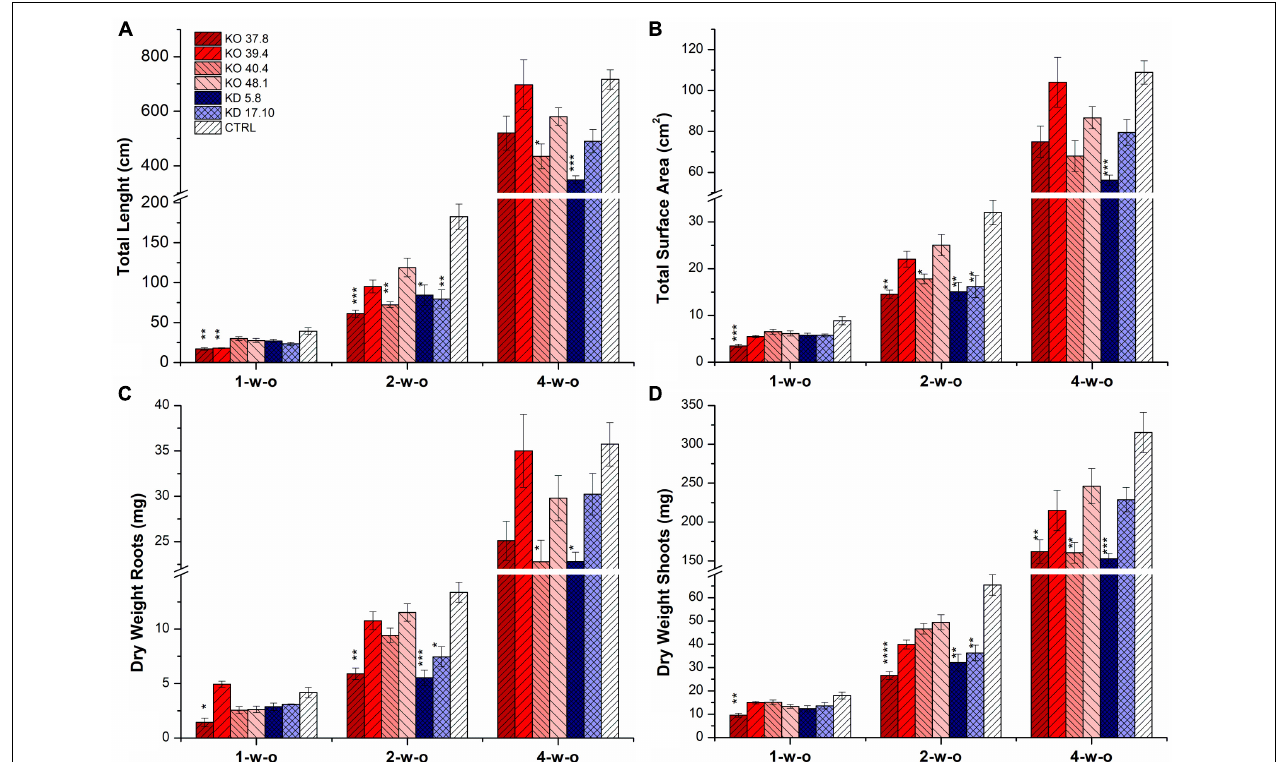
FIGURE 6 | Phenotyping of the root system of different KD-CKX1 and KO-CKX1 lines growing hydroponically. Total root length (A) , total root surface area (B) , dry weight of the roots (C) and dry weight of the shoots (D) of the KD-CKX1 plants (5.8 and 17.10), KO-CKX1 mutant lines (37.8, 39.4, 40.4, and 48.1) and control plants (CTRL). Plants were grown in hydroponic conditions in Hoagland solution in phytotron (photoperiod of 24 ◦ C/16 h/light and 22 ◦ C/8 h/dark) and harvested after one (1-w-o), two (2-w-o) and four (4-w-o) weeks. Total root length and total root surface area were determined with WinRHIZO software. Values are mean ± SE ( n = 9). A non-parametric Kruskal–Wallis Anova & Median test analysis was performed followed by a post hoc multiple comparison of mean rank (Statistica v. 13.3); ∗ p < 0.01, ∗∗ p < 0.001, ∗∗∗ p < 0.0001, ∗∗∗∗ p < 0.00001.